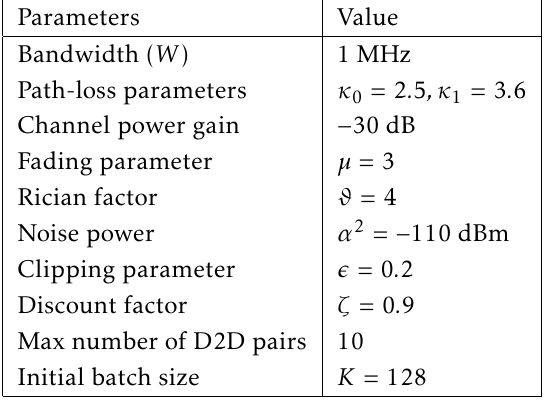
Table 1. SIMULATION